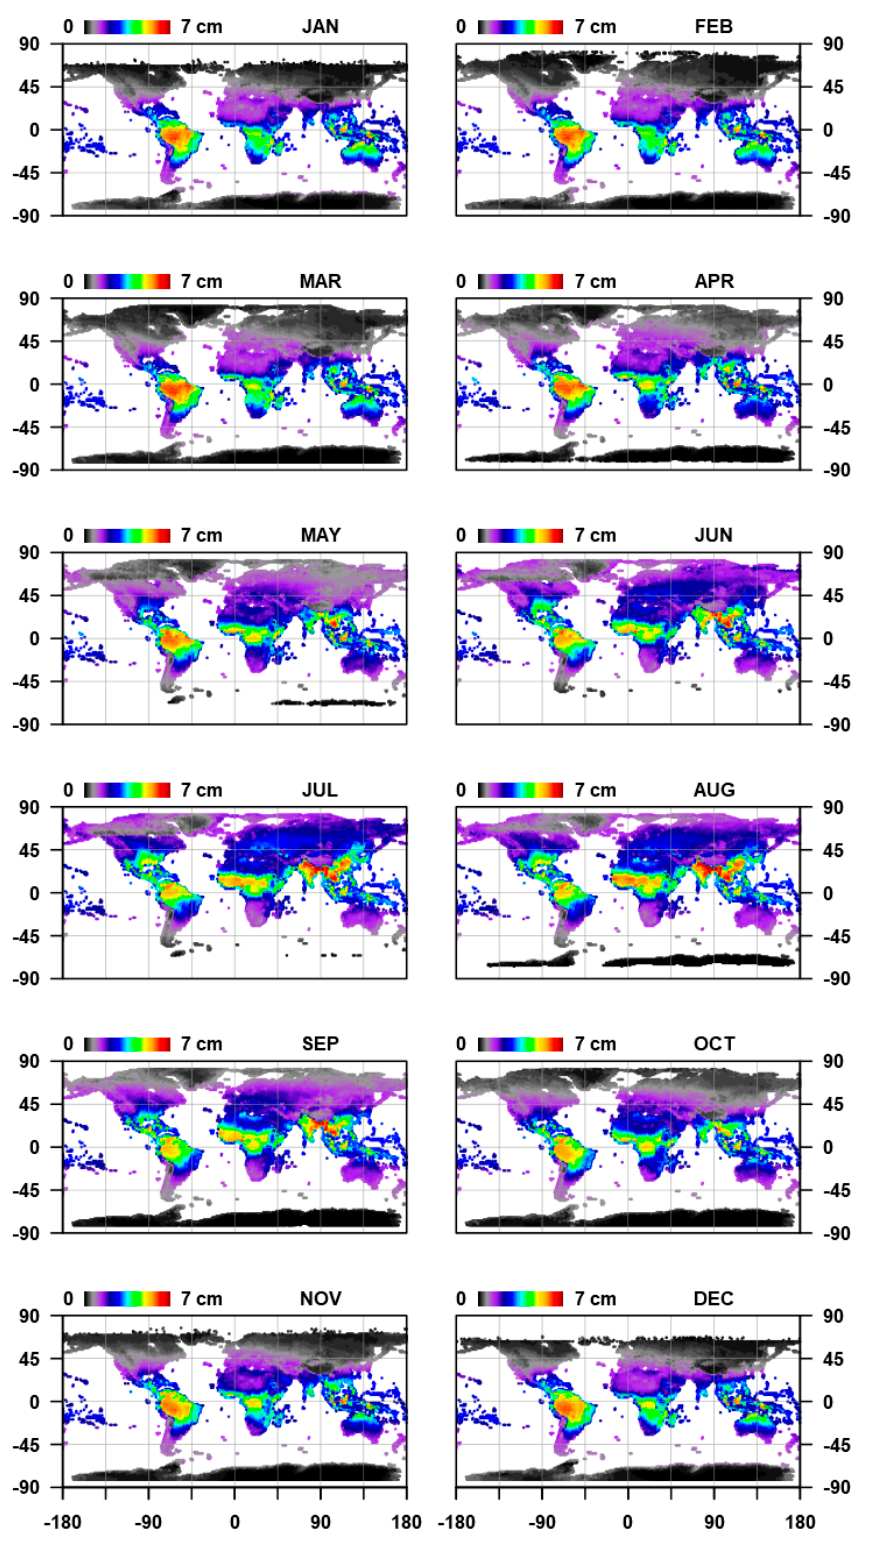
Figure 2. Long-term mean water vapor per month, averaged from February 2000–July 2018 based on daily values.